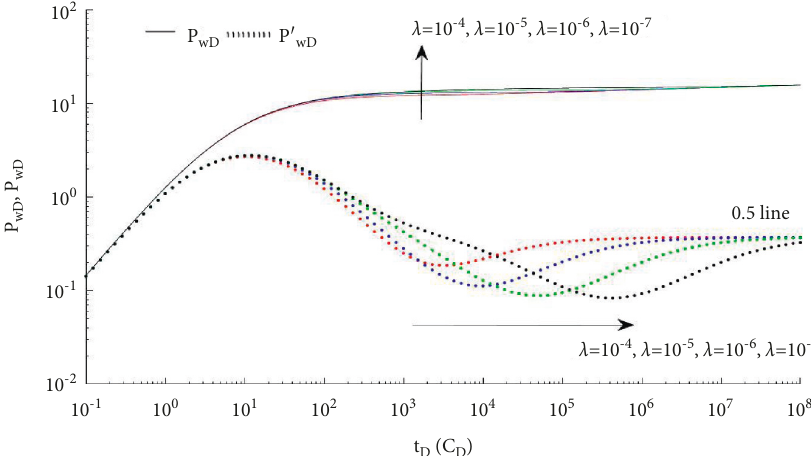
Figure 9: Dimensionless pressure of vertical wells under the infinite outer boundary influenced by λ ( C